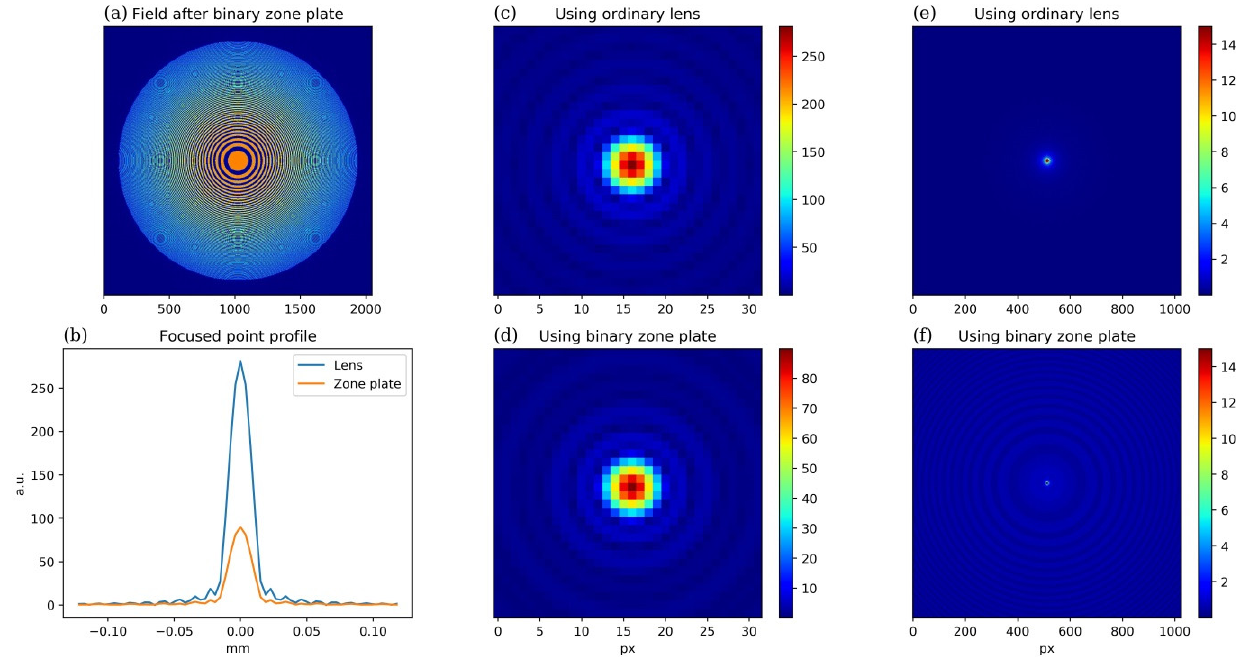
Figure 2. Beam focusing. ( a ) The modulus of the field passed through the Fresnel zone plate; ( b ) point source in-focus profiles ( x -axis is measured in millimeters). Orange line—using the zone plate, blue—using an ordinary lens of the same focal length; ( c , d ) images of a point source using the lens and the zone plate, respectively; ( e , f ) images matching images (c,d) but with large field of view (1024 px. instead of 32). The values of the color scales have been changed for wide “halo” highlighting in image ( f ) (the values of the modulus of the field themselves remained unchanged). The x-axes are measured in pixels, and the size of the x -axis is equal to the y -axis for all images except (b). Color bars are displayed as field strength in arbitrary units (a.u.). Pixel size is 3.8 μ m.